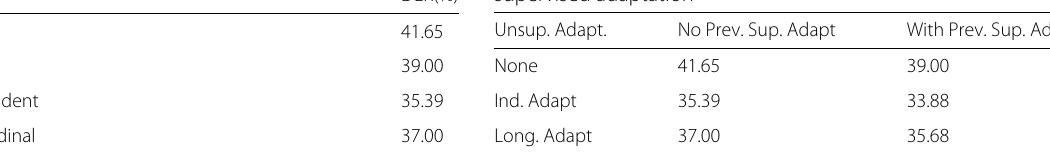
Table 5 DER (%) results of supervised and unsupervised (independent and longitudinal) adaptation with the new data distribution in the evaluation set Adaptation DER(%) Baseline 41.65 Supervised 39.00 Unsup. Independent Unsup. Longitudinal